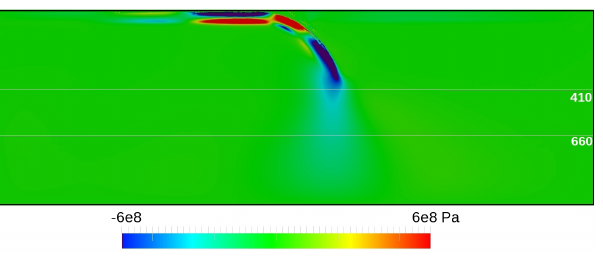
Fig. 2. Stress component τ 22 for the initial model with open bound- aries after 3.5My of kinematically forced evolution (Fig. 1a). Note the down-dip compression in the slab.